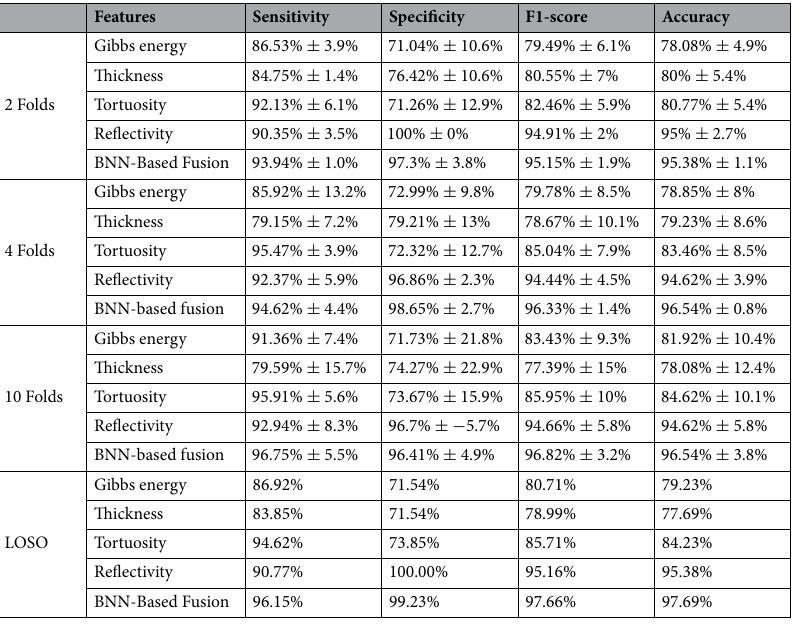
Table 4. The classification accuracy of the proposed BNN-based system compared with the performance of each marker separately. Note that: BNN and LOSO stand for backpropagation neural network and leave-one- subject-out, respectively.